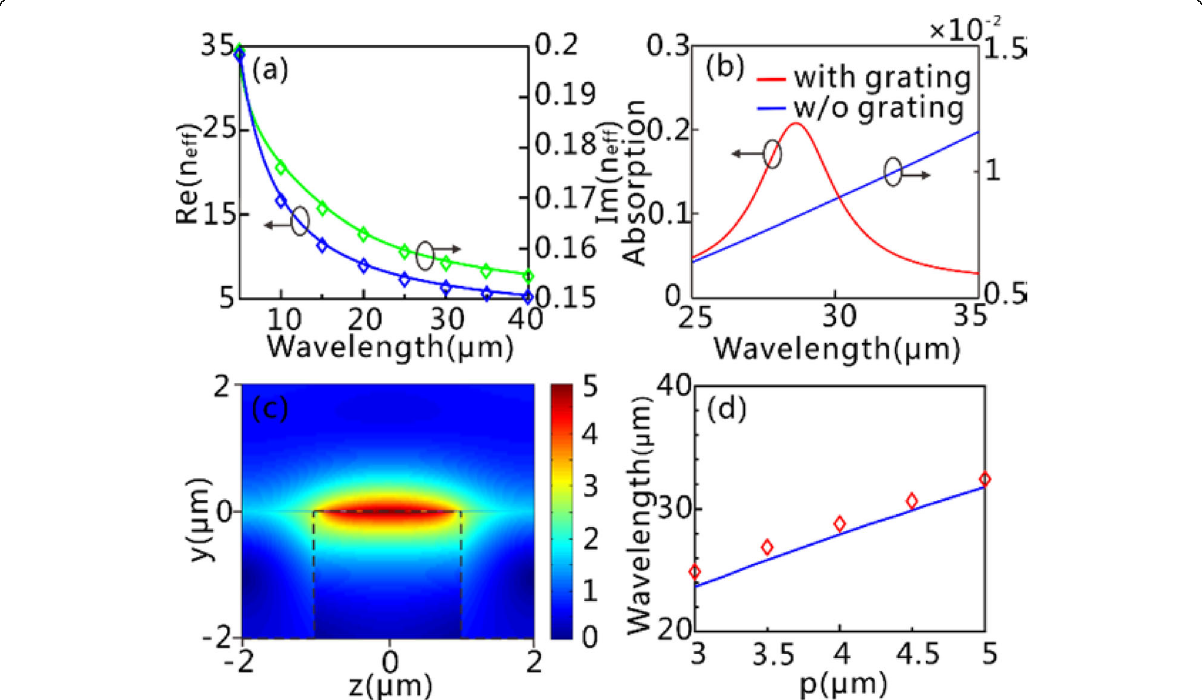
Fig. 3 FF GPs and field enhancement on the GSSDG. a Dispersion curves of the GPs on the GSSDG. The blue and green solid lines correspond to the real [Re( n eff )] and imaginary [Im( n eff )] part of the effective index retrieved from Eq. (3), respectively, while the blue and green rhombuses are gotten from numerical simulations. b Absorption spectrums with grating substrate (red line) and pure silicon substrate without the grating (blue line). c The normalized | E | distributions of the fundamental GPs mode at 28.62 μ m. The black dashed lines outline the silicon layer. d The excitation wavelength of the fundamental GPs mode versus the grating period. The blue line is retrieved from Eq. (6), and the red rhombuses are from numerical simulation. In b and c , P is set as 4 μ m. All the simulation results are retrieved by the commercial software Lumerical FDTD